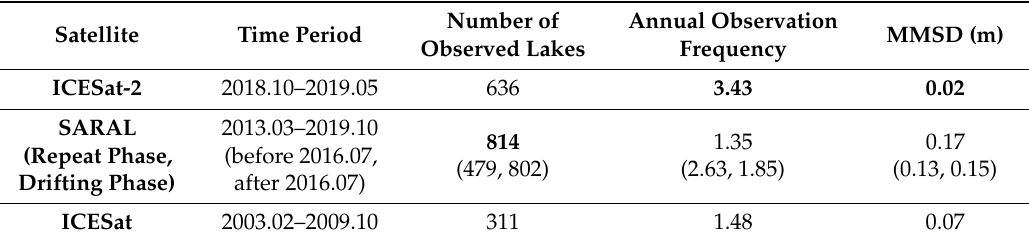
Table 2. Statistics on lake observations derived from the ICESat-2, ICESat, and SARAL data.